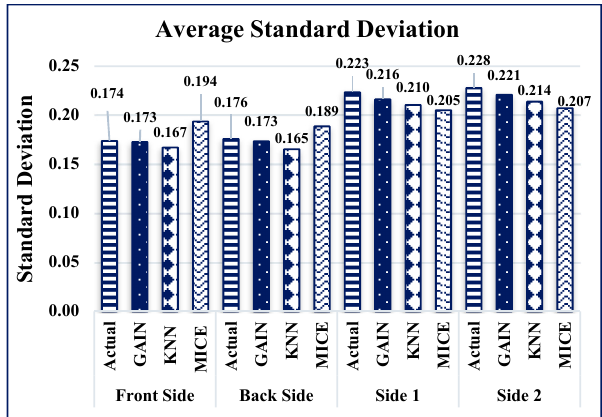
Figure 17. Average standard deviation comparison.